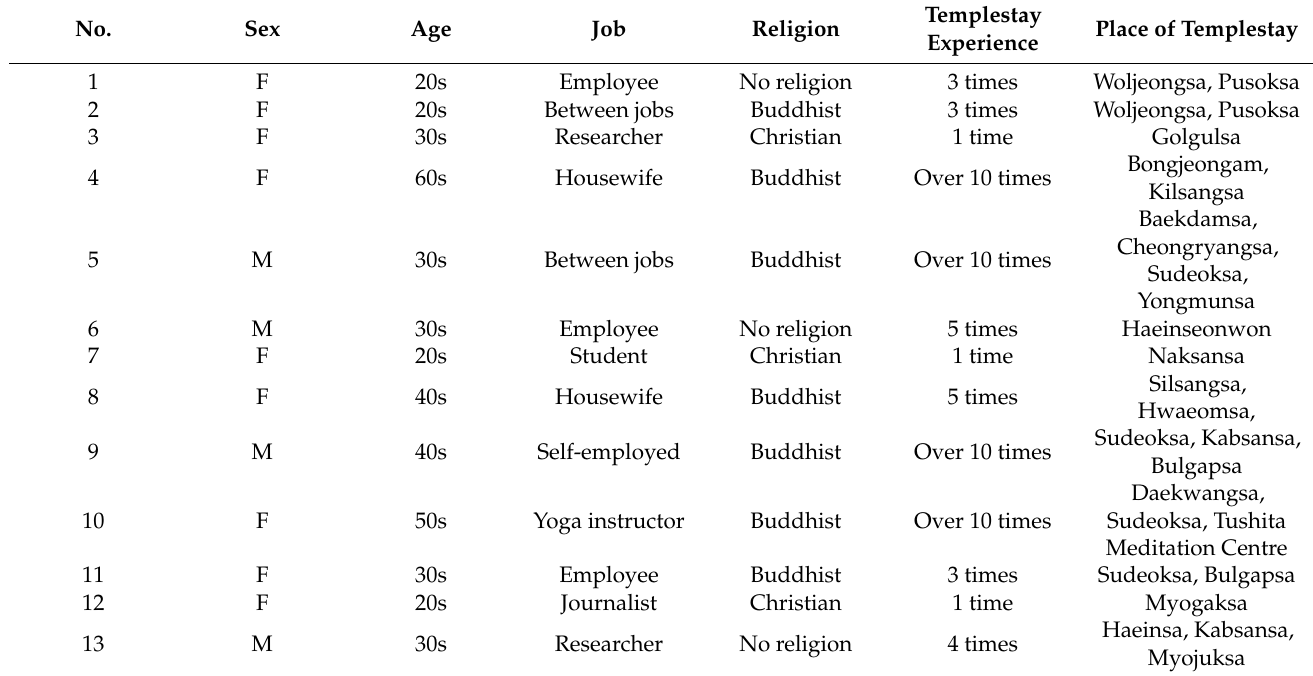
Table 1. Characteristics of